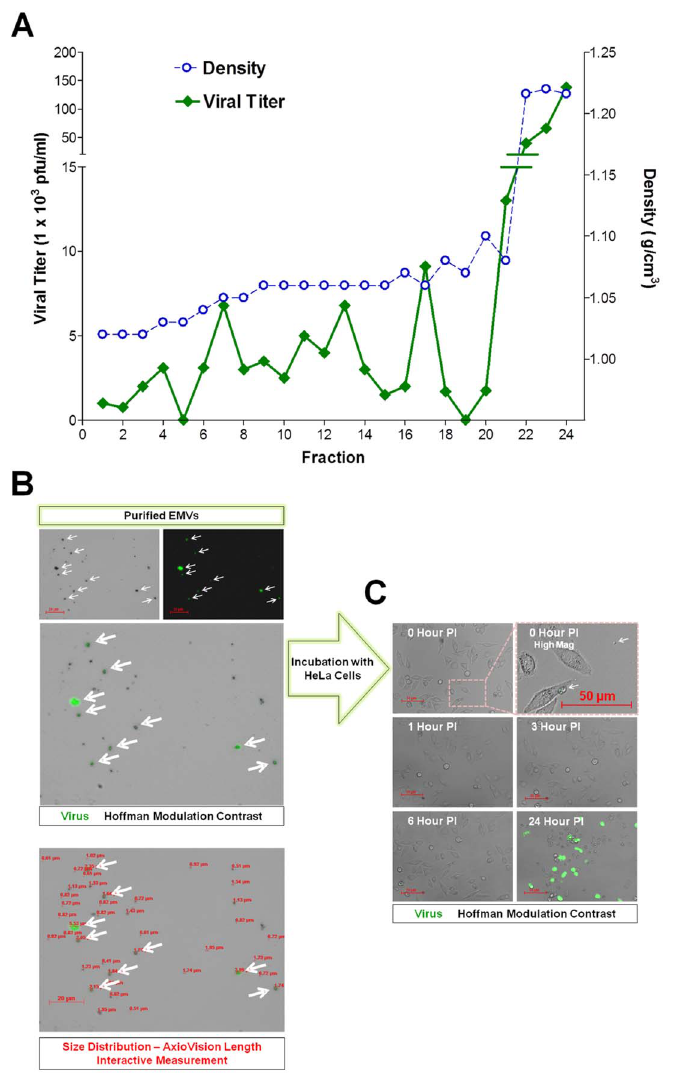
Figure 11. Purified EMVs isolated from infected progenitor cells contained infectious virus. (A) Supernatants from differentiated C2C12 cell cultures infected with eGFP-CVB3 were collected at day 3 PI and purified by Isopycnic gradient centrifugation. Buoyant density of infectious, membrane-associated EMVs released by C2C12 cells were observed within a range of 1.04–1.10 g cm 2 3 . In contrast, a separate peak of infectious virus was observed at a density expected for non-enveloped virions (1.22 g cm 2 3 ). (B) Shed microvesicles isolated from differentiated C2C12 cells infected with eGFP-CVB3 were collected at day 3 PI and purified utilizing the Exoquick-TC polymer-based exosome precipitation kit. Purified EMVs were resuspended in 1 6 DMEM and inspected by fluorescence microscopy for viral protein (eGFP) and size distribution using the Length Interactive Measurement feature in AxioVision software. (C) Purified EMVs were added to HeLa cell cultures, and virus protein expression was followed by fluorescence microscopy over 24 hours PI.